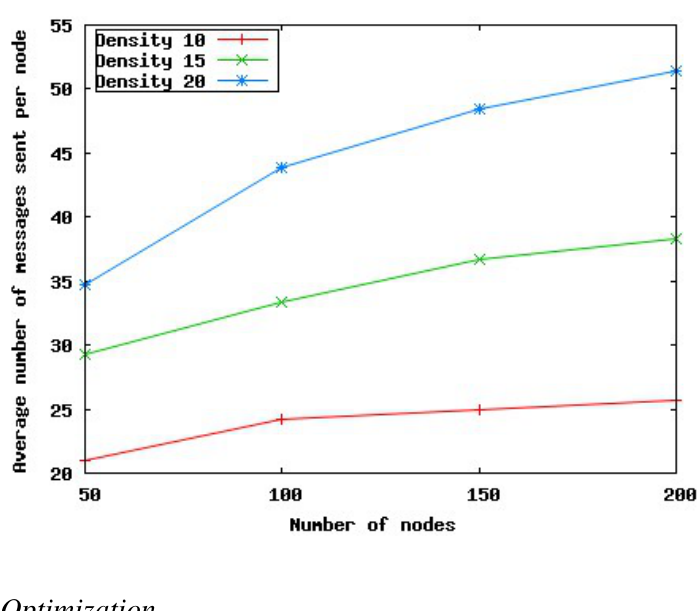
Figure 11. Average number of messages sent per